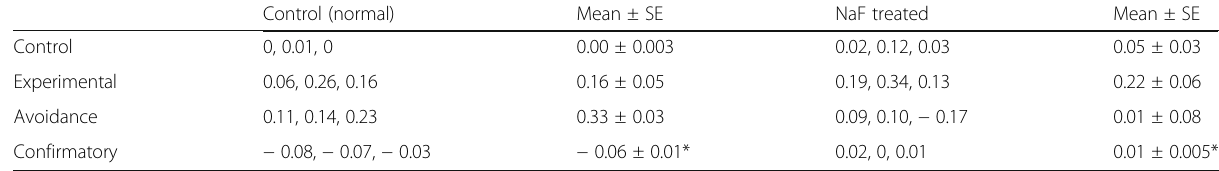
Table 7 Comparison of Olfactory Response Index of 2nd instar larvae of normal and fluoride-treated Zaprionus